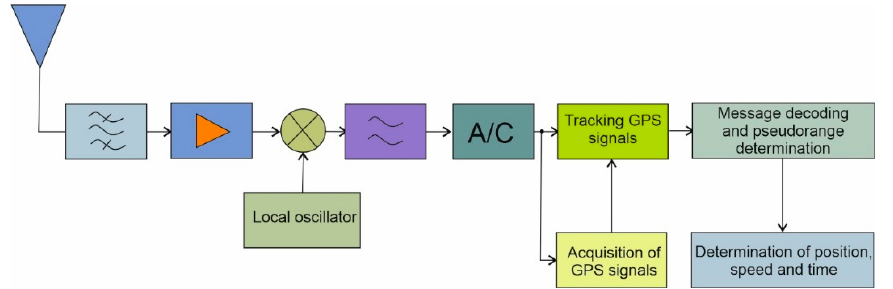
Figure 1. Block diagram of the GPS receiver.